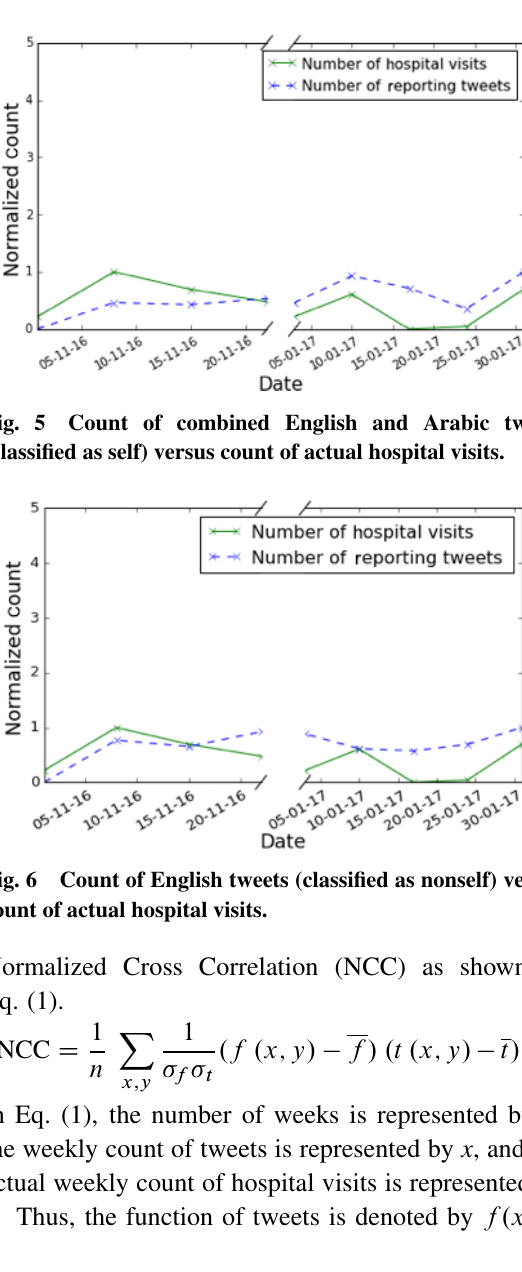
Fig. 4 Count of Arabic tweets (classified as self) versus count of actual hospital visits.